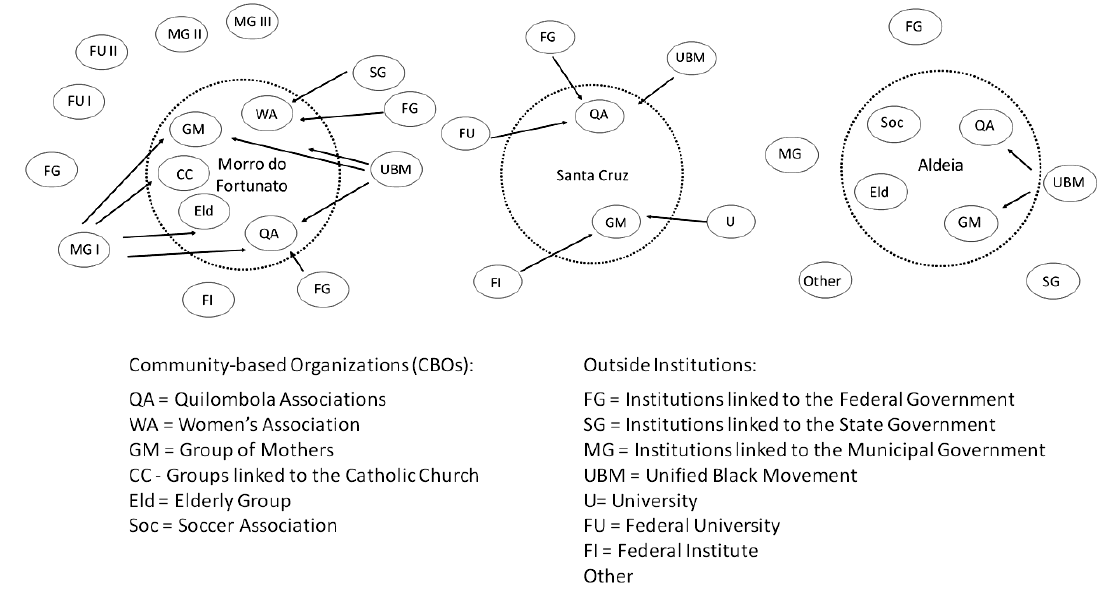
Fig. 7 . Social networks of the Quilombola communities, on the southern coast of Brazil. Organizations within the dotted circle are community-based organizations (CBOs) and those outside the circle are partners in levels above the community. The arrows indicate partnership between